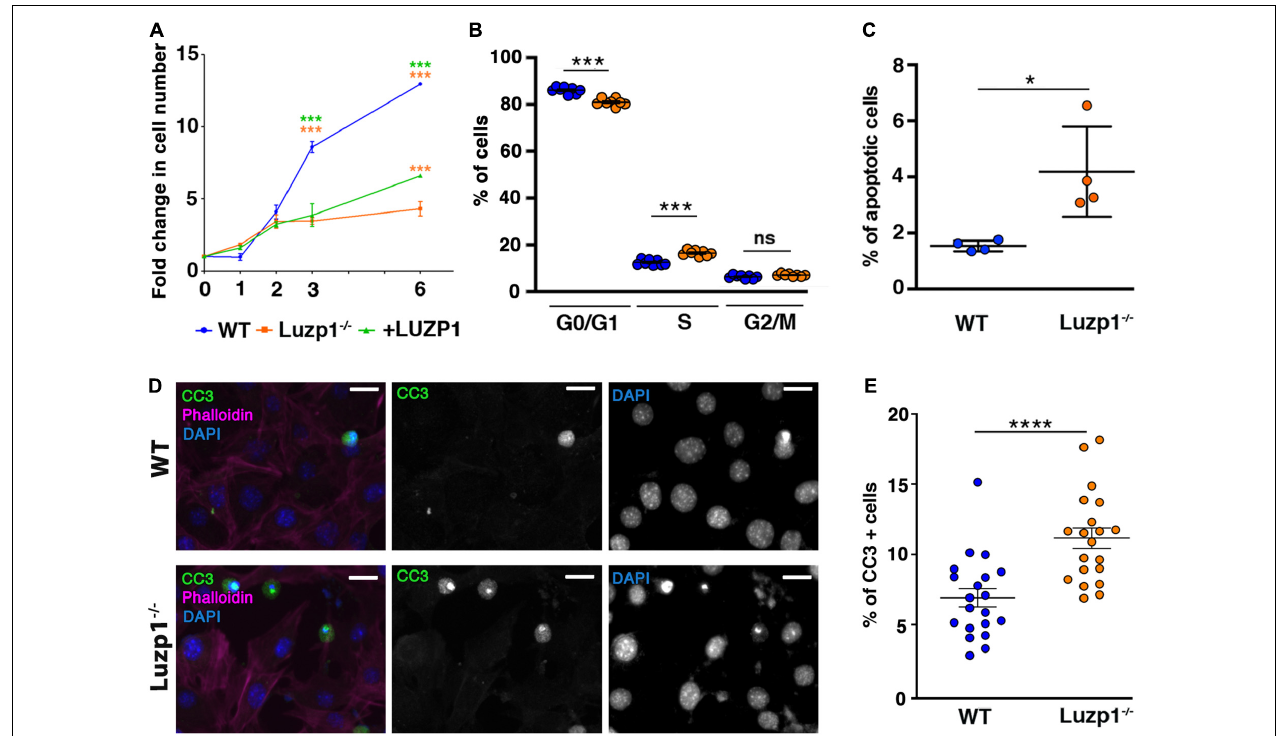
FIGURE 3 | Luzp1 − / − cells exhibit lower viability and higher apoptosis than WT. (A) Graphical representation of fold change in cell numbers of WT ( n = 5; blue line), Luzp1 − / − ( n = 5; orange line) and + LUZP1 cells ( n = 5; green line). P -values were calculated using Two-way ANOVA and Sidak’s multiple comparisons test. (B) Graphical representation of the percentage of WT (blue dots) and Luzp1 − / − cells (orange dots) in G0/G1, S or G2/M phases analyzed by EdU labeling and QIBC. P -values were calculated using Two-way ANOVA. (C) Graphical representation of the results of FACS analysis in Supplementary Figure S1B using Annexin V and DRAQ7 staining to determine the percentage of apoptotic cells in WT and Luzp1 − / − cells in ( n = 4). P -value was calculated using Mann Whitney- U test. (D) Representative micrographs showing WT and Luzp1 − / − cells stained with the marker of mid-stage apoptosis cleaved caspase-3 (CC3) (green), phalloidin (magenta), and DAPI (blue). Black and white images show the single green and blue channels. Images were detected using Zeiss fluorescence microscope (Axio Imager D1), × 40 objective. Scale bar: 25 µ m. (E) Graphical representation of quantification of CC3-positive cells in (D) showing the percentage of apoptotic cells in WT and Luzp1 − / − cells ( n = 20 micrographs, objective 20x). P -value was calculated using Mann Whitney- U test. The graphs in (A–C,E) represent the Mean and SEM. ∗ P < 0.05; ∗∗∗ P < 0.001; ∗∗∗∗ P <